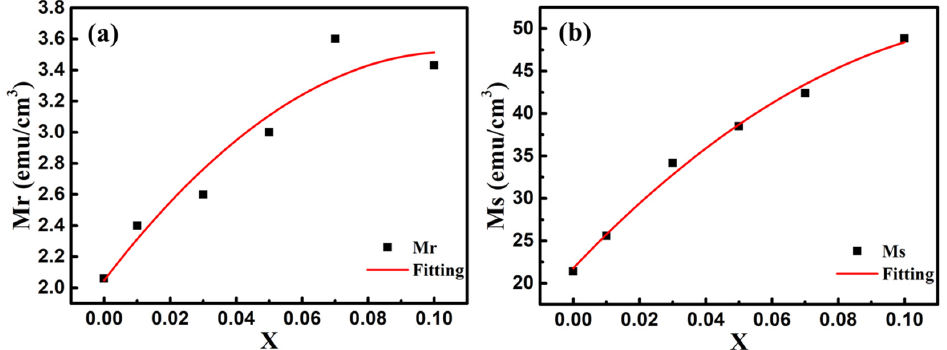
Figure 10. The changes of ( a ) remanent magnetization (Mr) and ( b ) saturation magnetization (Ms) values with Co doping concentration. Red lines are the simulated results according to the binomial polynomial